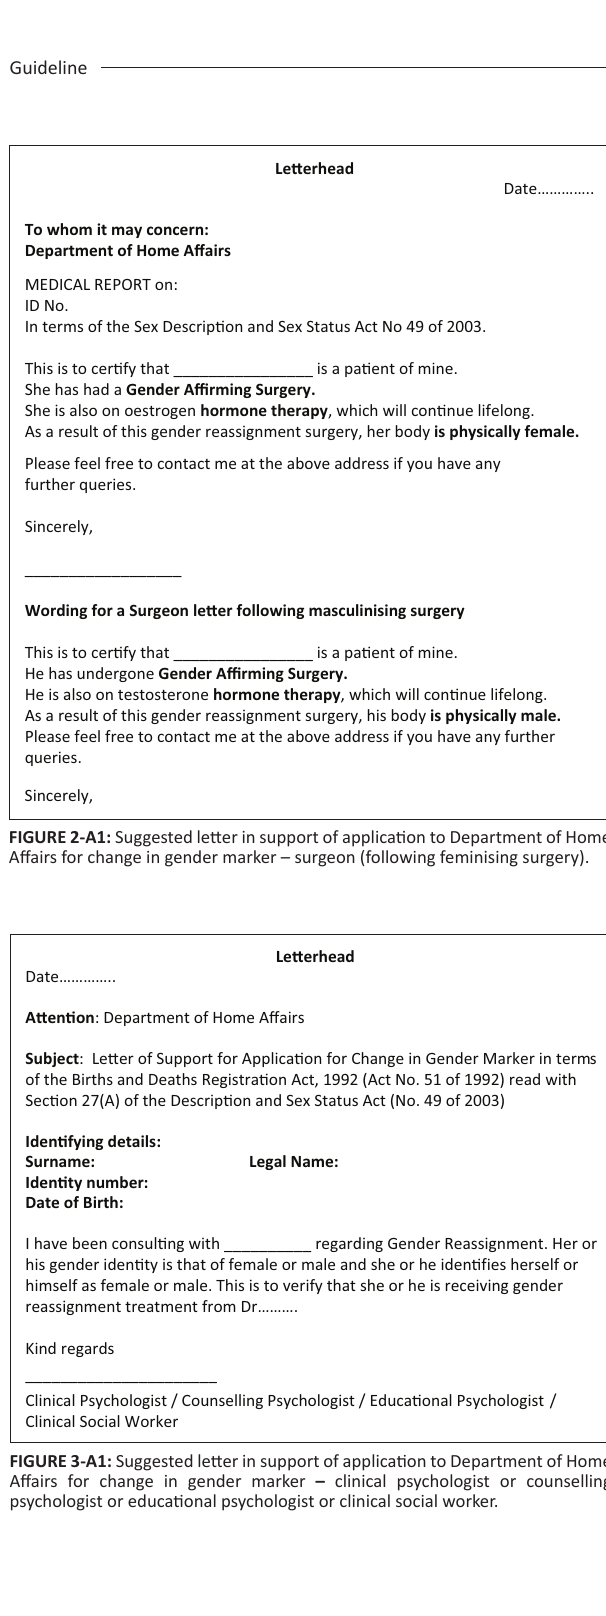
FIGURE 1-A1: Suggested letter in support of application to Department of Home Affairs for change in gender marker – Medical doctor.